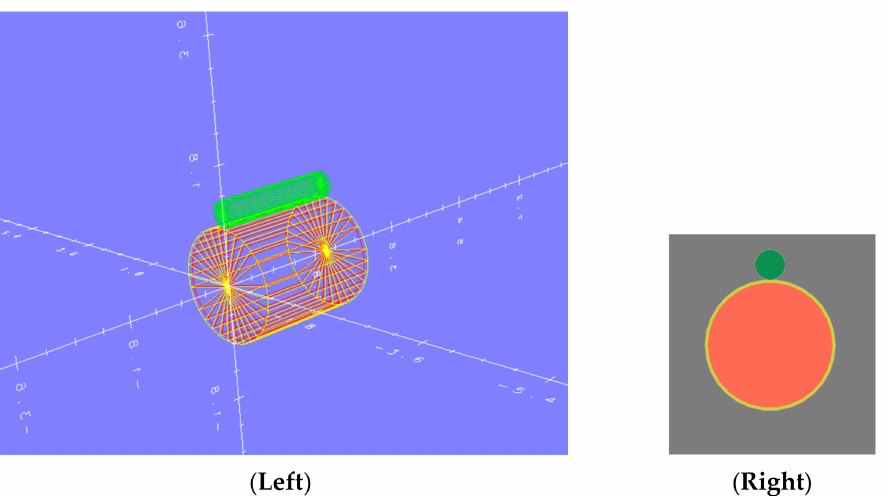
Figure 4. ( Left ): The simulated model of a rat’s head containing three cylindrical bodies: an inner cylinder that represents the brain tissue (red), an outer cylinder that represents the skull surrounding the brain (yellow), and the cylindrical tumor/dosimeter (green). ( Right ): cross sectional